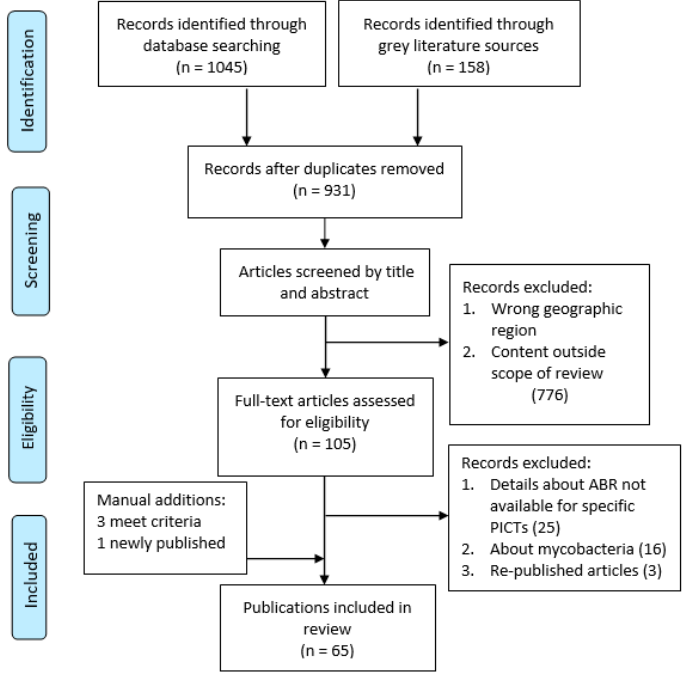
Figure 1. Prisma flow chart detailing article selection process.